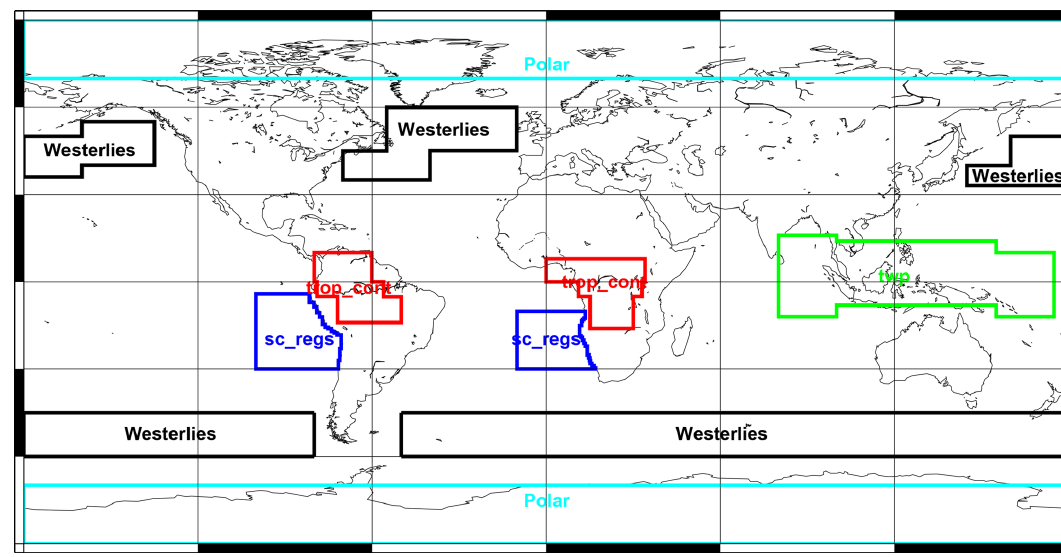
Figure 6. A map of the regions selected for further investigation adapted from Eliasson et al. (2011, Fig. 9).